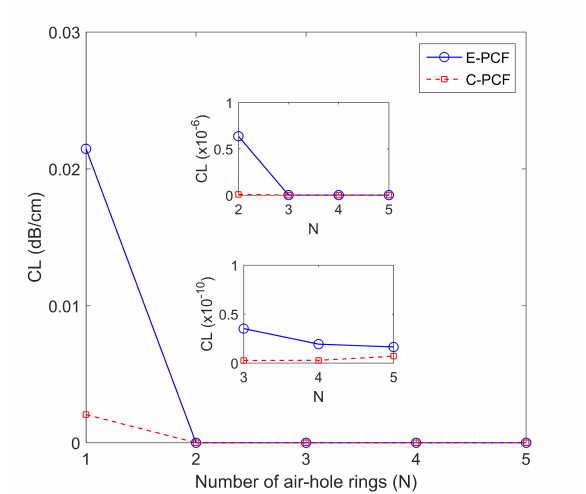
Figure 5. Confinement loss (CL) of PCF with circular-core and elliptical-core as a function of the number of air-hole rings at 1550 nm. The C-PCF parameters are: d / Λ = 0.692, d c / Λ = 0.876 and Λ = 0.867 µ m, and E-PCF parameters are b / a = 0.75 and a = 1 µ m. The insets show the trend of CL for N > 2 (top inset) and N > 3 (bottom